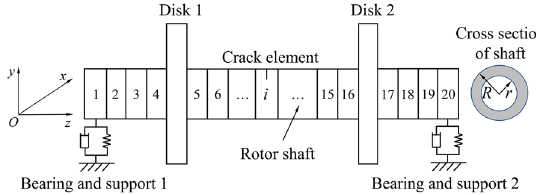
Figure 1 Finite element model of a cracked two-disk hollow shaft rotor system